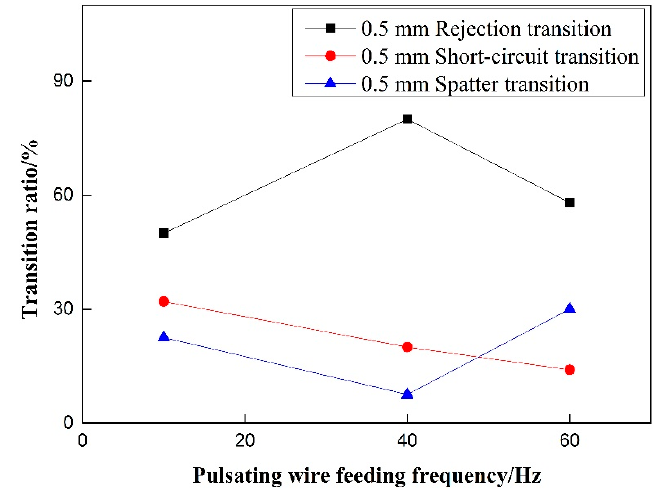
Figure 14. Effect of pulsating wire feeding frequency on transition ratio under 0.5 mm withdrawal quantity.